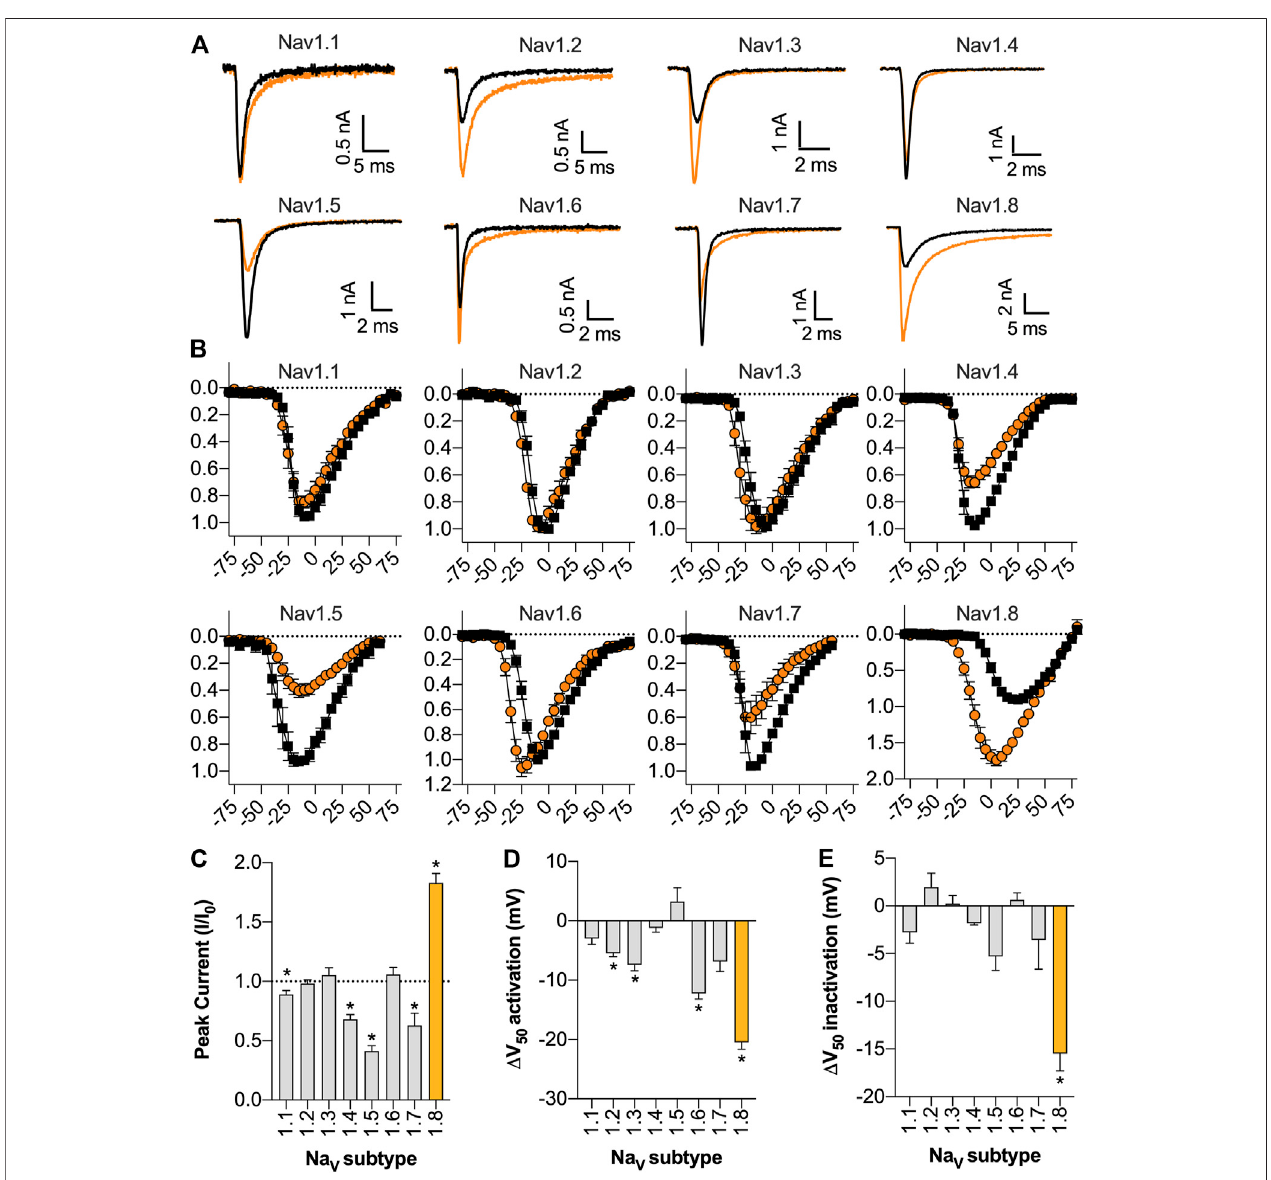
FIGURE 3 | Selectivity of Eo1a at Na V 1.1 to Na V 1.8. (A) Representative Na V 1.1 to 1.8 current traces before (black) and after addition of 10 μ M Eo1a (orange). Currents were elicited by a 50 ms pulse to − 20 mV (for Na V 1.1 to Na V 1.7) or to +10 mV (for Na V 1.8) from a holding potential of − 90 mV. (B) I - V relationship before and afteradditionof10 μ MEo1aatNa V 1.1toNa V 1.8.Na V 1.8panelissameaspresentedin Figure2C butincludedagainhereforcomparison.y-axesrepresentnormalised current( I / I 0 )andx-axesrepresentmembranepotential(mV). (C) Peakcurrenttakenfromthe I - V protocol(atanyvoltage)afteradditionof10 μ